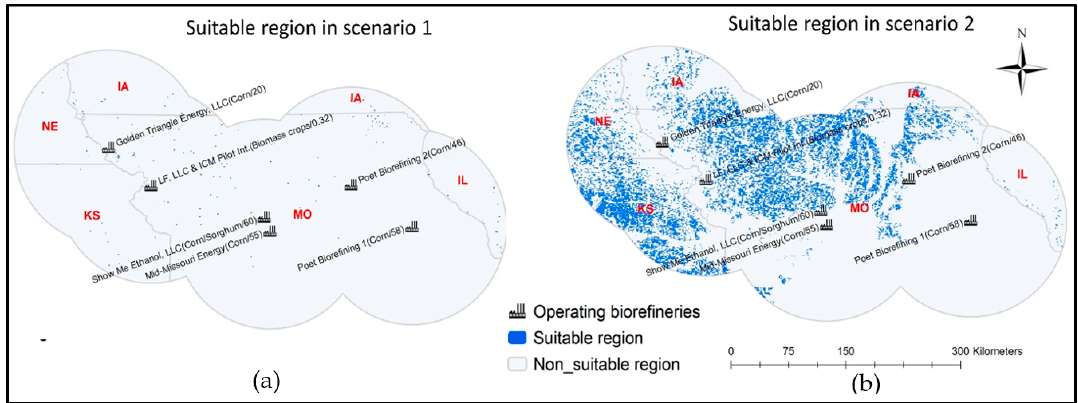
Figure 3. Suitable switchgrass cultivation. ( a ) in scenario 1, ( b ) in scenario 2. The plant name is presented with its feedstock and capacity. State abbreviations are in red.